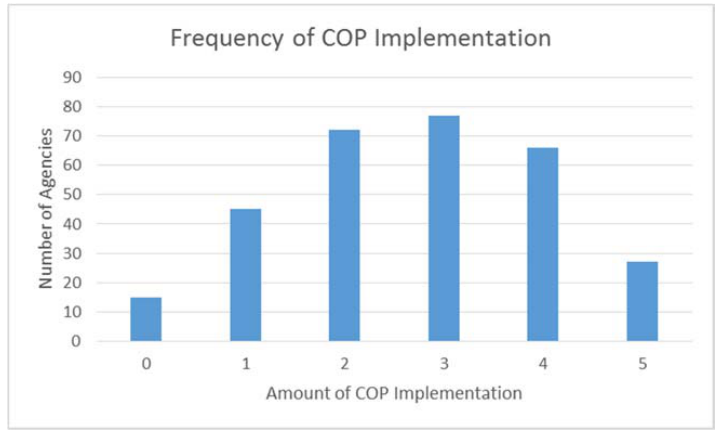
Figure 1. Frequency of COP implementation.